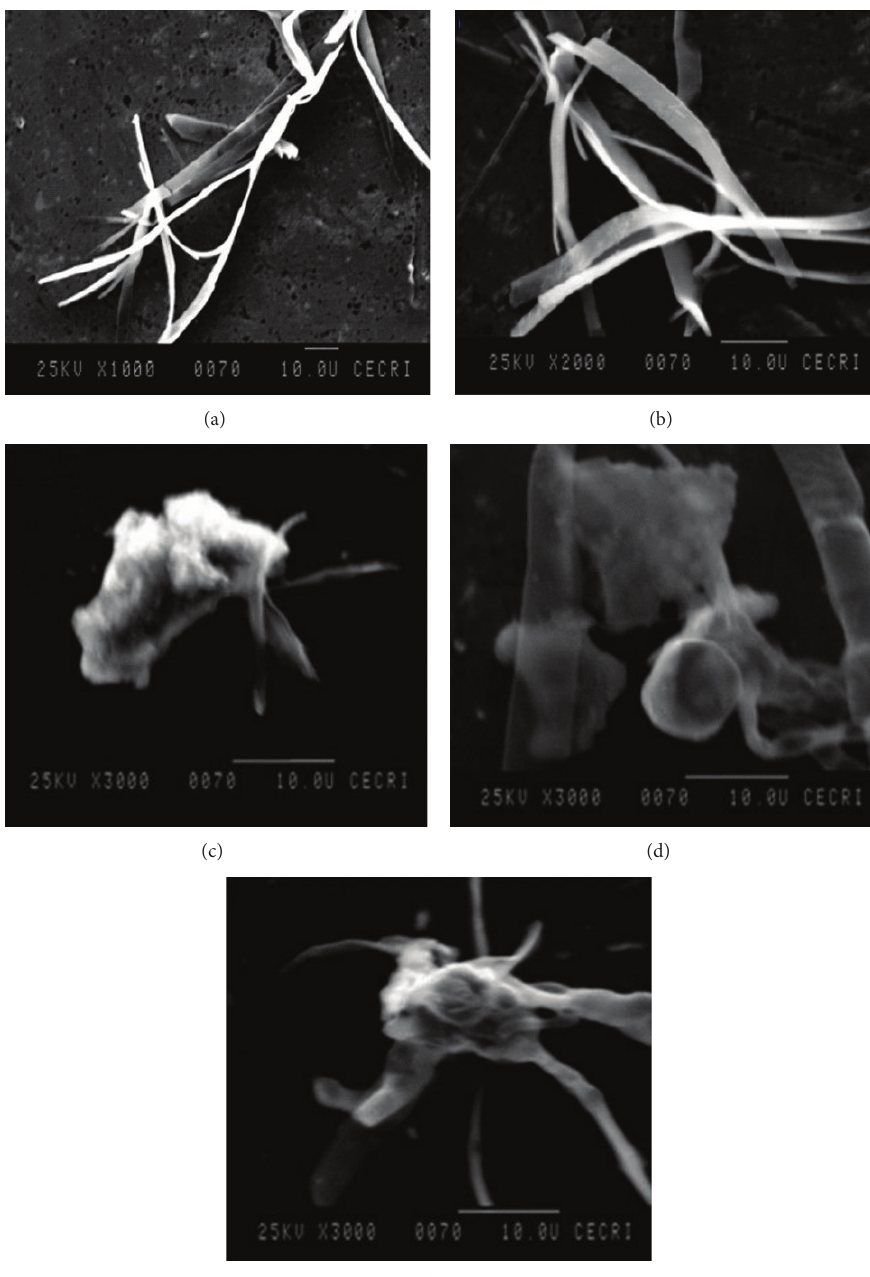
Figure 7: SEM images of (a) and (b) BEF ligand, (c) BEF–Cu, (d) BEF–Ni, and (e)